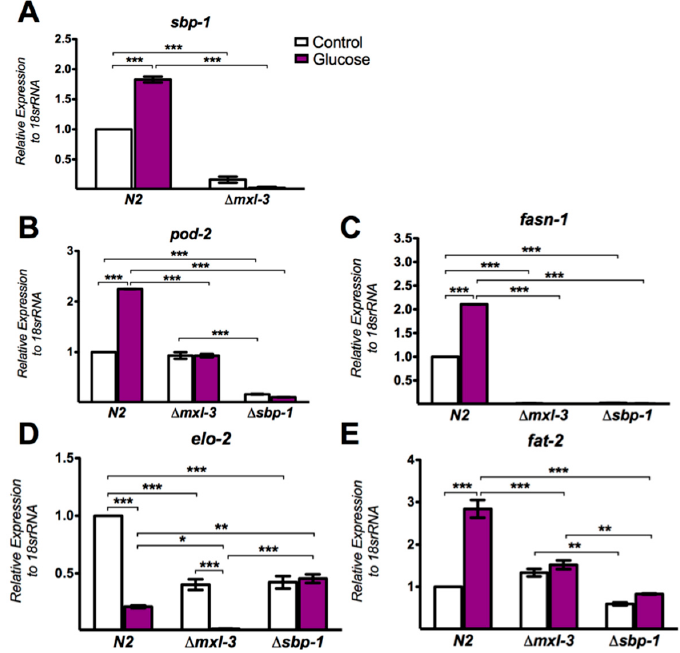
Figure 3. Transcriptional control of lipid-related genes by MXL-3. The relative mRNA expression levels of several genes: ( A ) sbp-1 ; ( B ) pod-2 ; ( C ) fasn-1 ; ( D ) elo-2 ; and ( E ) fat-2 in N2 wild-type or mxl-3 and sbp-1 mutant strains. Mutation of mxl-3 significantly decreased sbp-1 mRNA levels under both control and high-glucose conditions. Similar results were observed for elo-2 and fasn-1 , whereas no effects on pod-2 and fat-2 were observed. The relative expression of each gene was normalized to endogenous 18S rRNA gene expression. Data represent the mean ± SEM of three independent experiments; * p < 0.05, ** p < 0.01, *** p < 0.001, one-way ANOVA with Bonferroni’s post hoc test ** p < 0.01, *** p < 0.001, one-way ANOVA with Bonferroni’s post hoc test using GraphPad using GraphPad Prism.